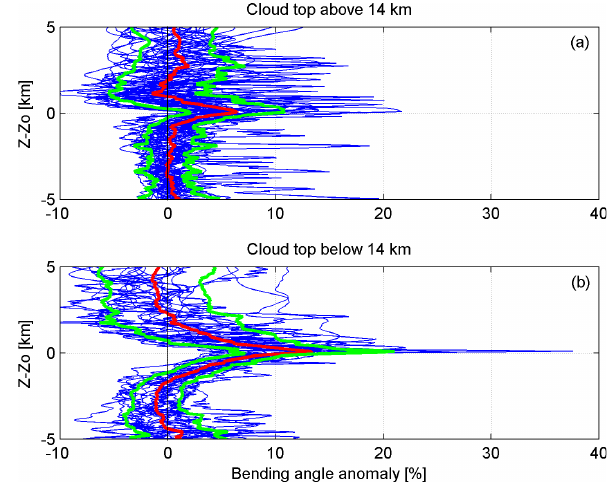
Fig. 5. Scatter plot showing correlation between cloud top height derived from GPS RO (identified from the maximum bending angle anomaly) and the maximum cloud top height from CALIOP.